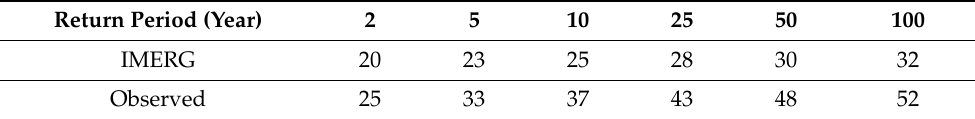
Table 1. Calculated return period precipitation events (mm/day) from various datasets. Return Period